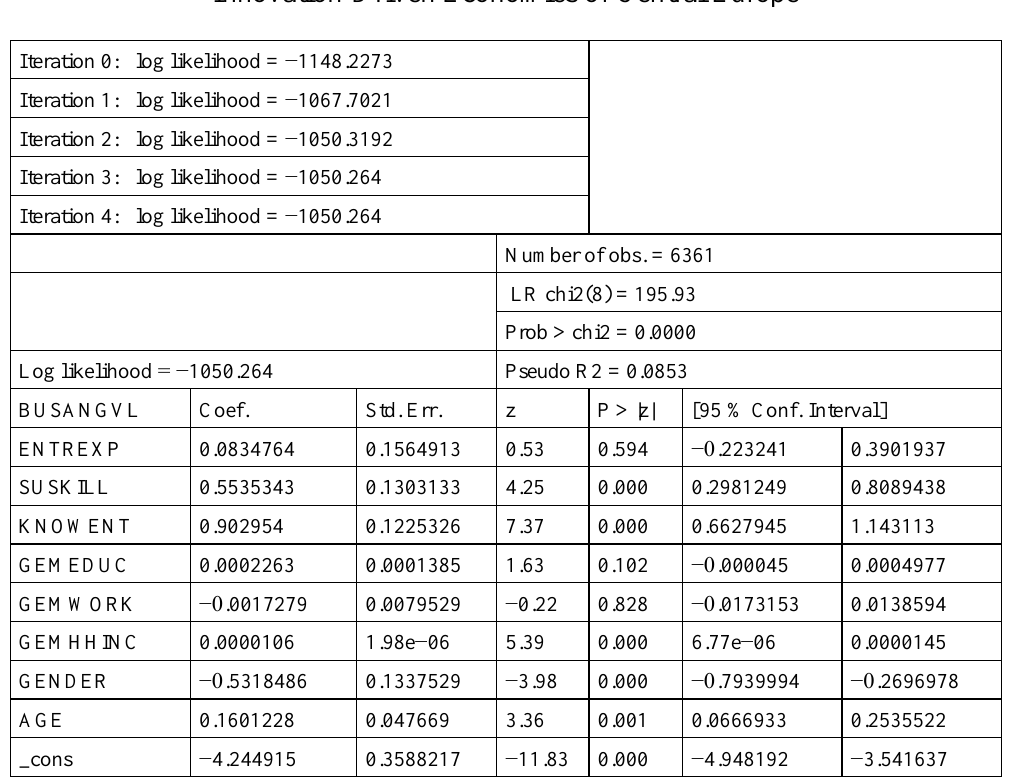
Table 3. The Logistic Regression Estimation of Informal Investment in the Innovation-Driven Economies of Central